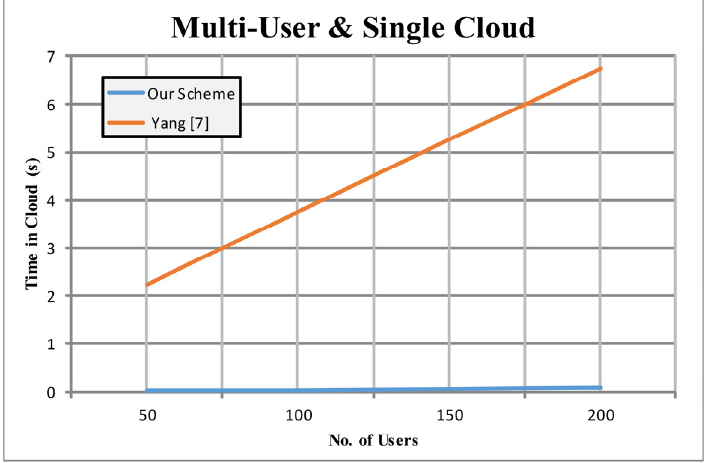
Figure 8. Computation cost for the IoT ‐ cloud system with a multi smart device user and single cloud.